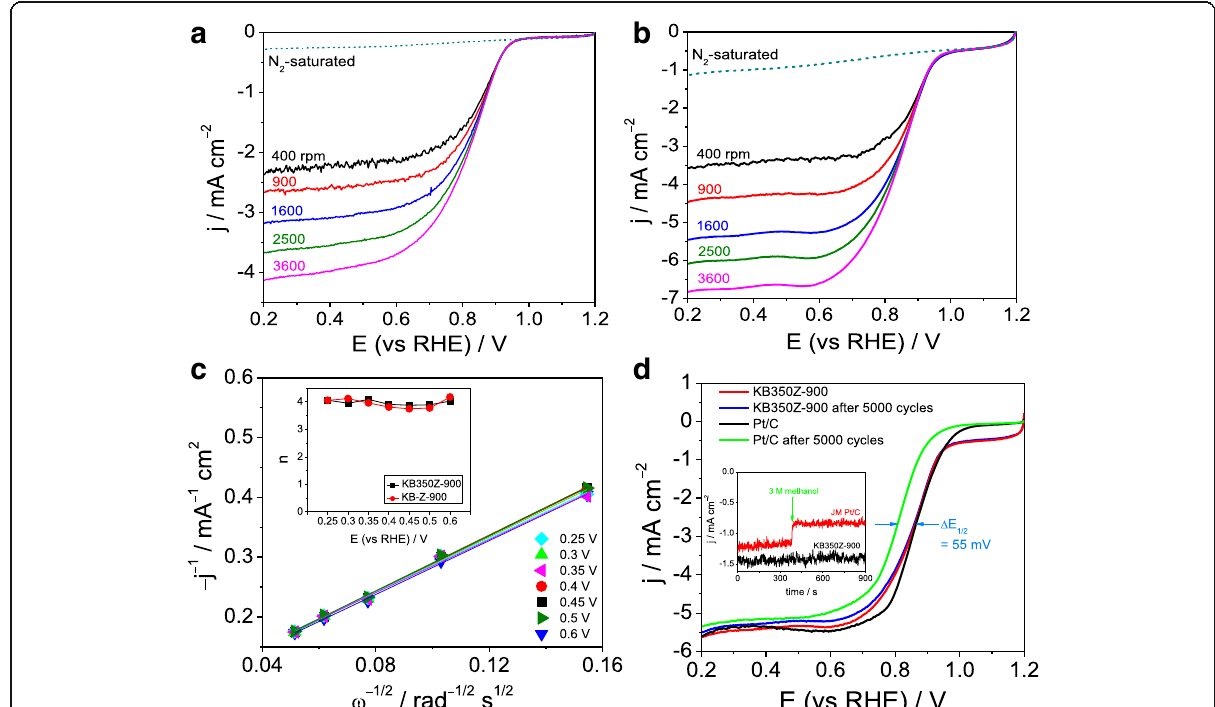
Fig. 4 a LSV curves of KB-Z-900 in N 2 versus O 2 saturated KOH solution at different rotation rates; b LSV curves of KB350Z-900 in N 2 versus O 2 saturated KOH solution at different rotation rates; c Koutecky-Levich plots of j d − 1 versus ω − 1/2 obtained from ( b ) at the given potentials (0.25 – 0.6 V). Inset is the plots of n versus potential obtained from ( a ) and ( b ); d LSV curves of KB350Z-900 and JM Pt/C before and after CV for 5000 cycles in O 2 saturated KOH solution; Inset is amperometric i-t curves at 0.9 V versus RHE for methanol-tolerant